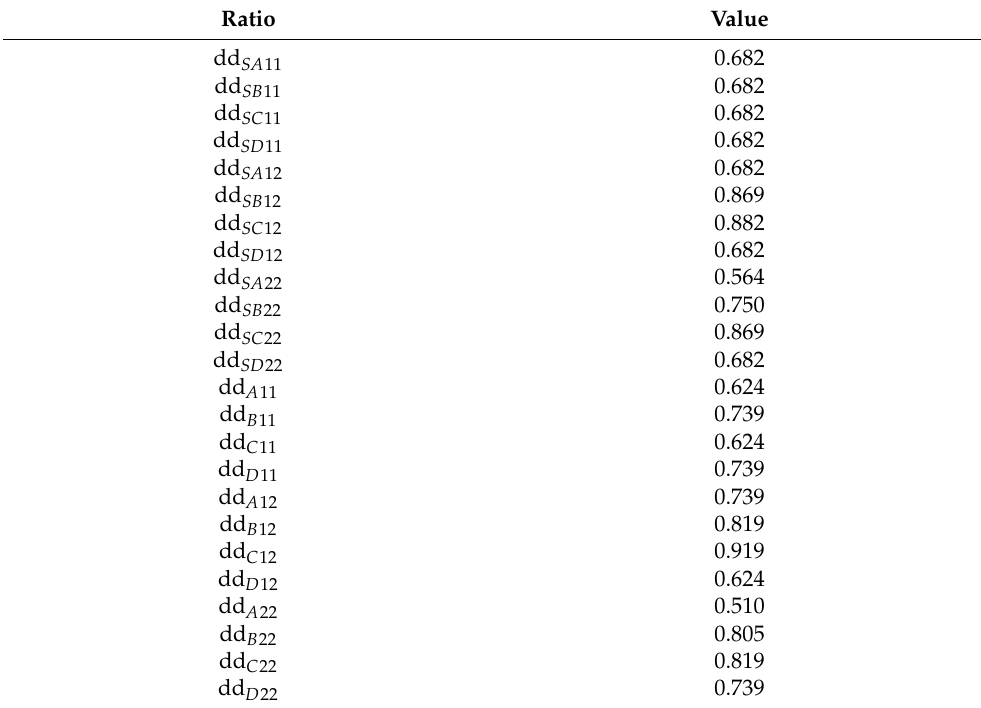
Table A5. The initial division coefficients defining the positions of the points S Aij , S Bij , S Cij , S Dij and the B v ’s vertices of the second structure Σ 2 for i , j = 1, 2.